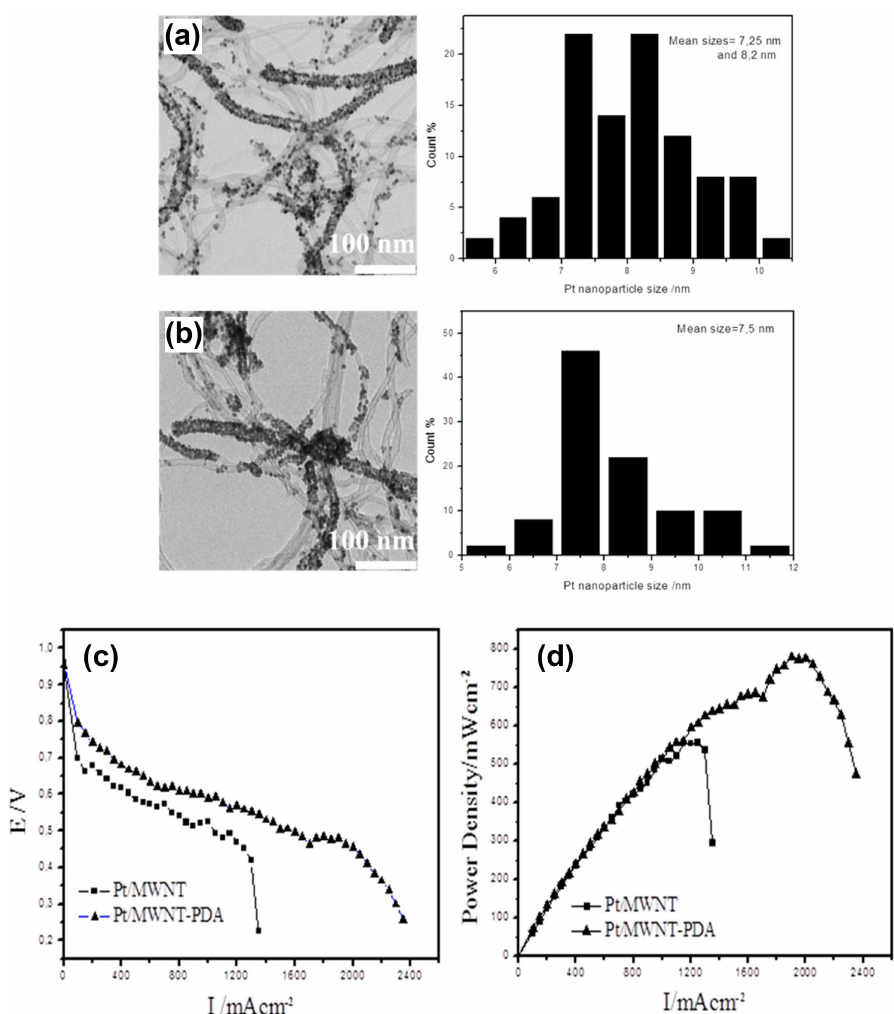
Figure 1. Transmission electron microscopy (TEM) images and corresponding particle size distribution histograms of ( a ) Pt-decorated multi-walled carbon nanotubes (Pt/MWNTs) and ( b ) Pt/MWNTs with polydopamine (Pt/MWNTs-PDA) catalysts used in the design of polyelectrolyte membrane-based fuel cells. ( c ) Polarization and ( d ) power density curves of fuel cell (Pt/MWNTs) 50 and (Pt/MWNTs-PDA) 50 . The composite membranes were produced by 50 spray cycles on a hot substrate. Reprinted from [22], Copyright (2016), with permission from